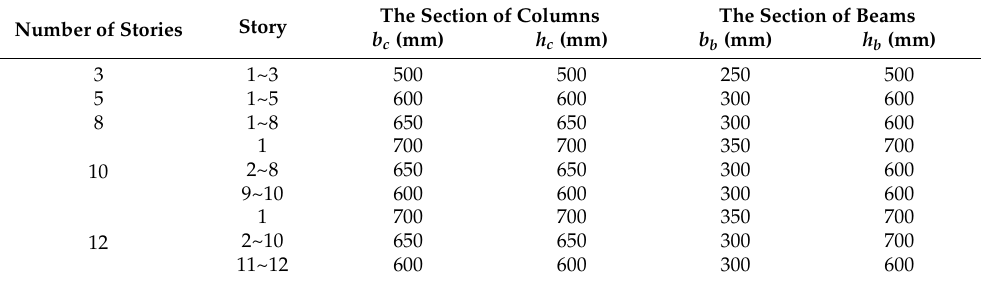
Table 1. Dimensions of beams and columns in